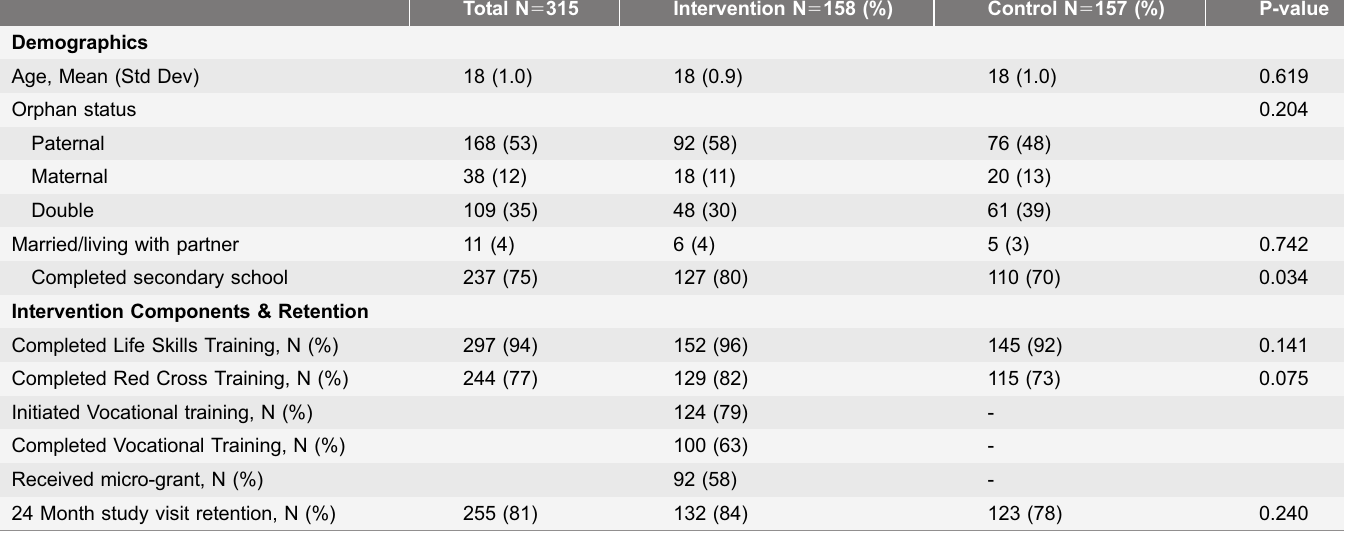
Table 1. Baseline Characteristics, Intervention Fidelity and Retention, by Study